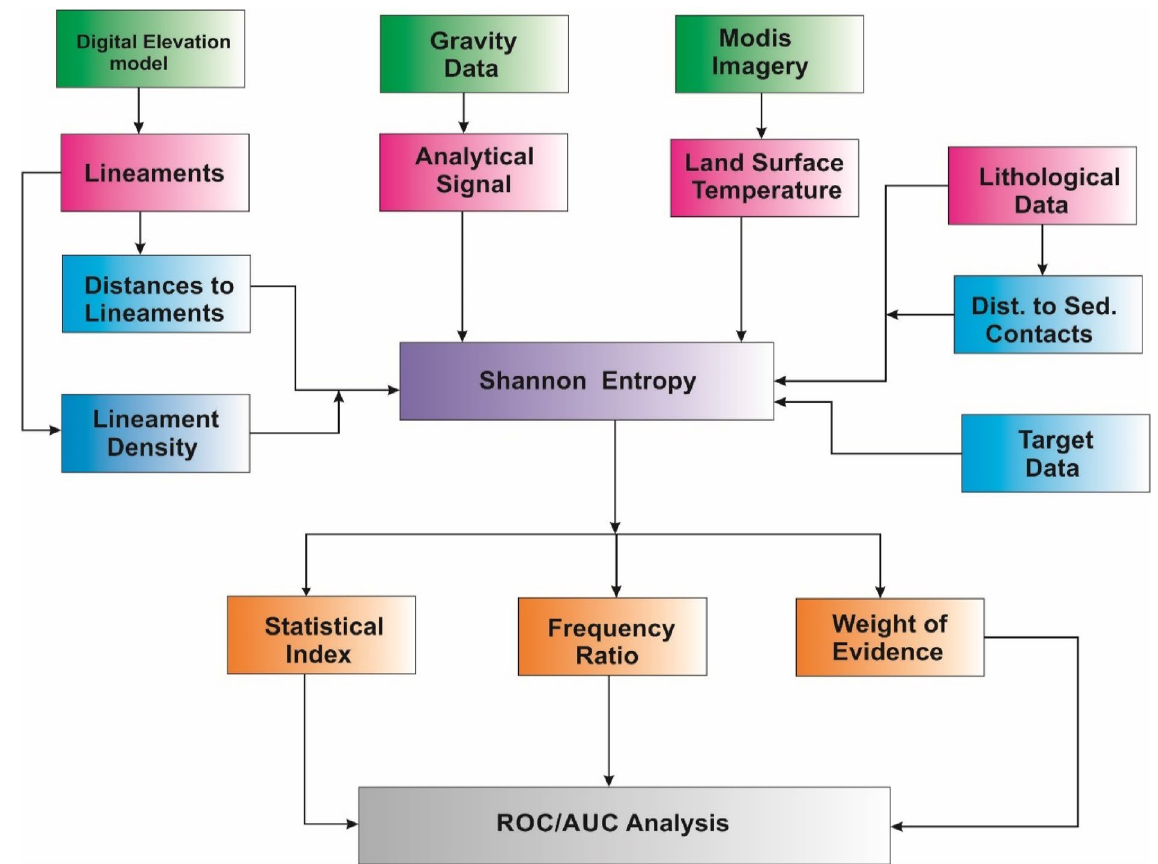
Figure 4. Flowchart illustrating the methods used in the